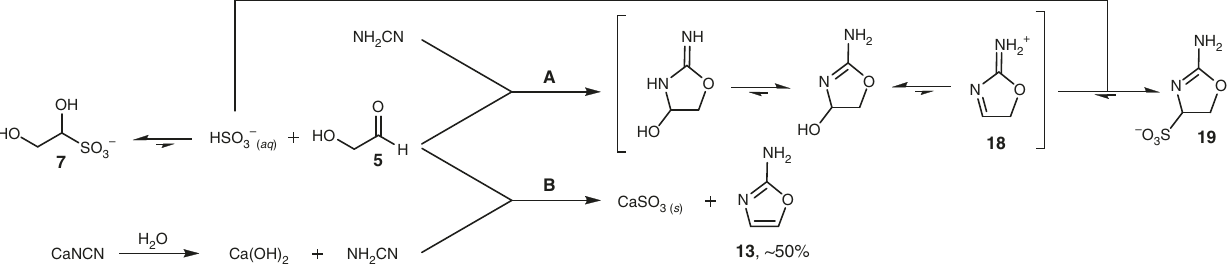
Fig. 6 Reactions of 7 with NH 2 CN and CaNCN. The use of cyanamide, when attempting to form 2-AO 13 from 7 (pathway A), results in the undesirable reaction of displaced bisul fi te with 18 , but using calcium cyanamide circumvents this problem by precipitating calcium sul fi te (pathway B)